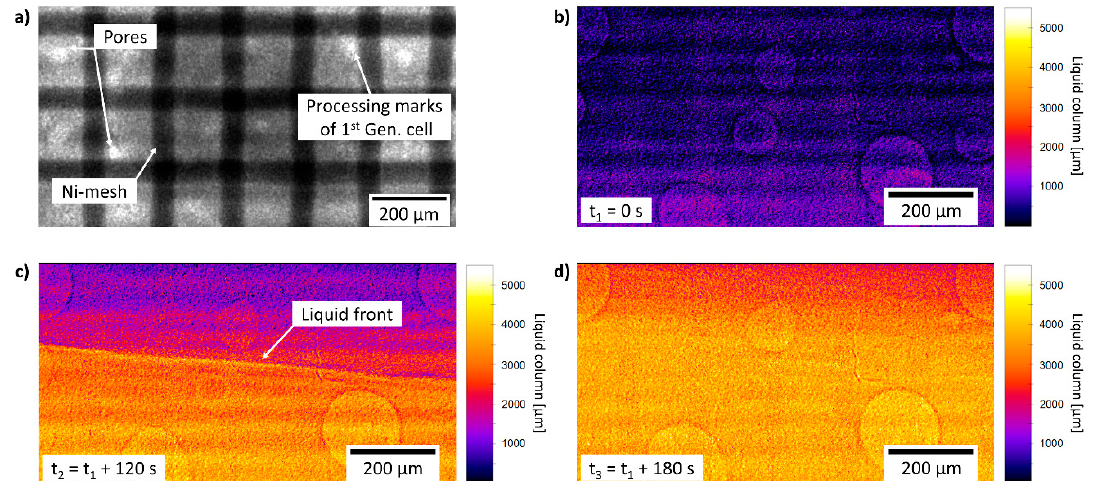
Figure 3. Images of oxygen-depolarized cathode (ODC) obtained by synchrotron radiation in 1 st Gen. cell, ( a ) microstructure of ODC as obtained; ( b – d ) normalized (by dry cell) images of filling process of 1 st Gen. cell with deionized water, the liquid front is clearly visible.